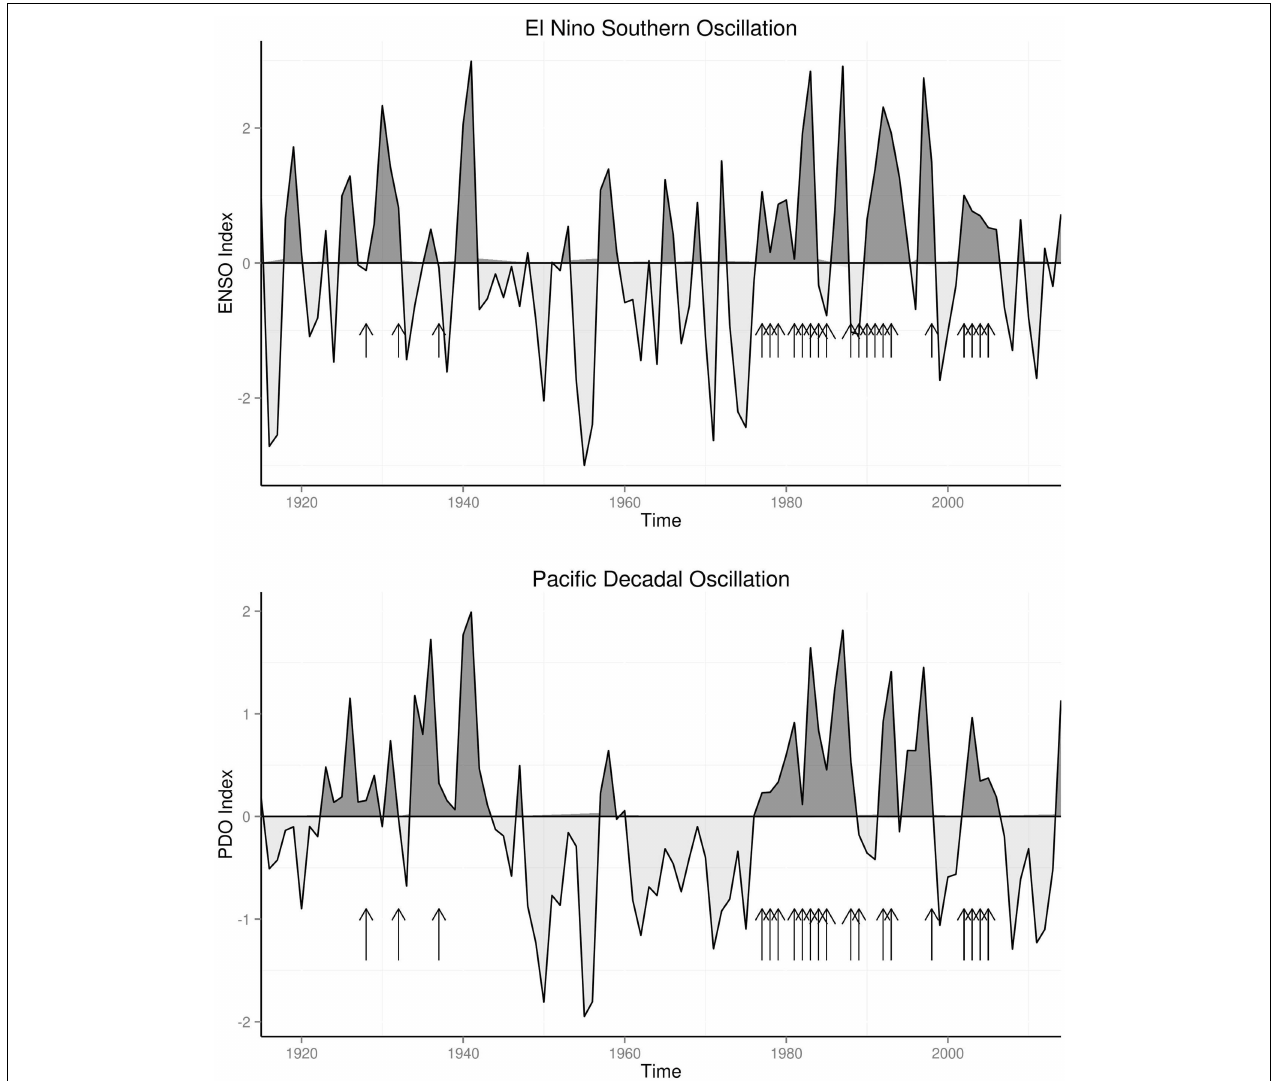
FIGURE 1 | Konzo Epidemics and Climate Regimes.